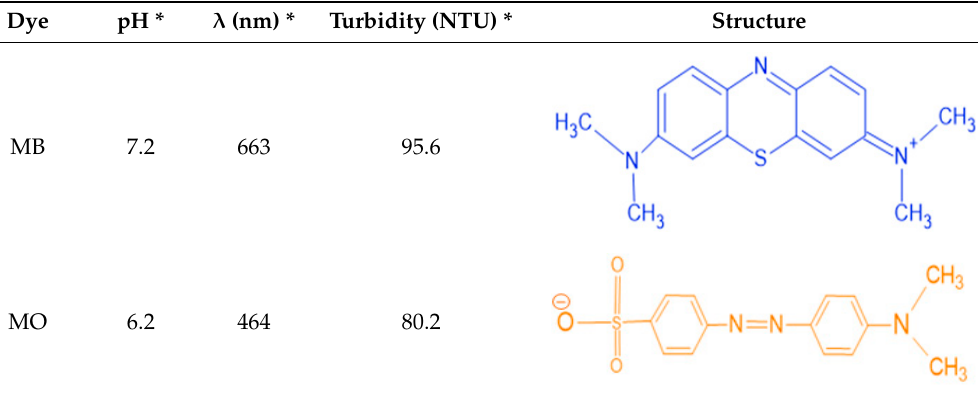
Table 2. Physico-chemical characteristics of methylene blue (MB) and methyl orange (MO).